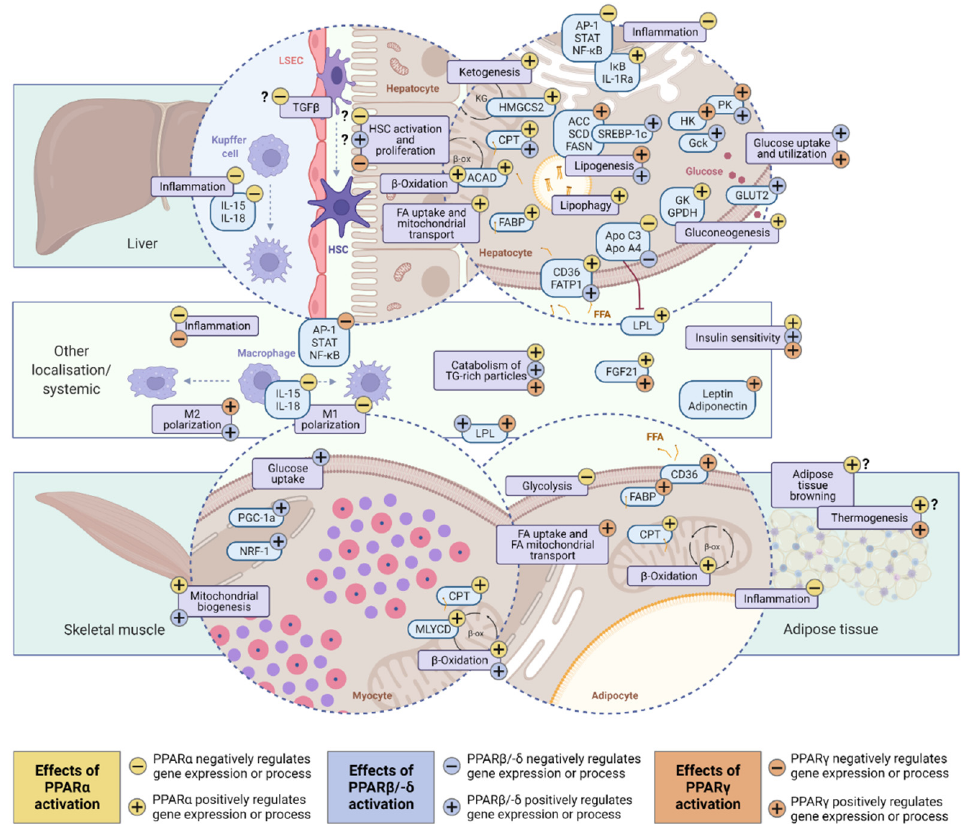
Figure 1. Overview of main tissue-specific and systemic effects of PPAR activation. Blue fields indicate proteins, purple fields indicate biochemical processes. Question marks indicate effects that are suspected but not confirmed. Red bars indicate inhibition. Created with BioRender.com. Abbreviations: β -ox, beta oxidation; ACAD, acyl-CoA dehydrogenases; ACC, acetyl-CoA carboxylase; AP-1, activator protein-1; Apo A4, apolipoprotein A4; Apo C3, apolipoprotein C3; CPT, carnitine palmitoyl- transferases; FA, fatty acid; FABP, fatty acid binding protein; FASN, fatty acid synthase; FATP1, fatty acid transport protein-1; FFA, free fatty acid; FGF21, fibroblast growth factor 21; Gck,